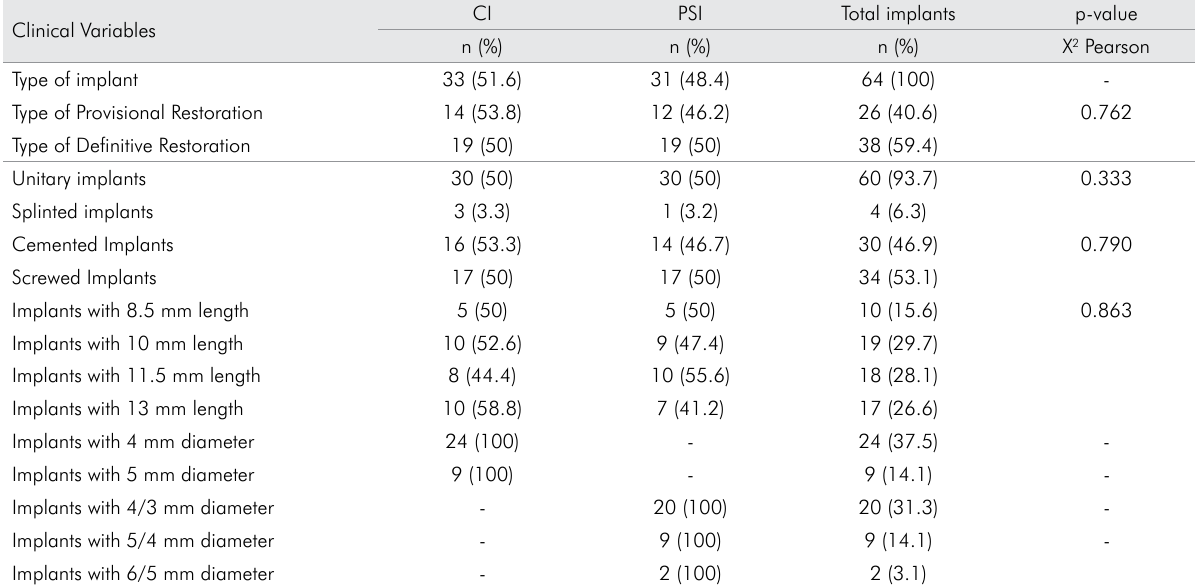
Table 1. Conventional Implants (CI) and platform switching implants (PSI) characteristics in terms of length, diameter, design and type of prosthetic restoration.